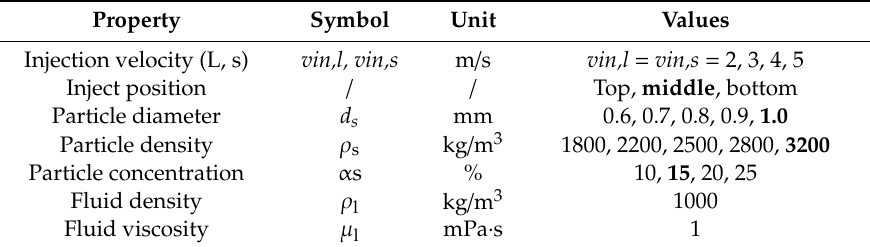
Table 2. Parameter sets for parametric study and primary data for simulation.